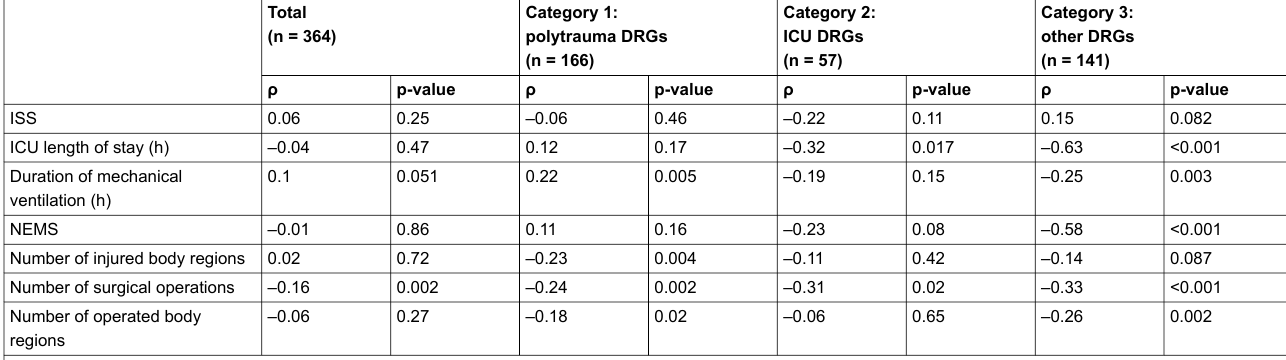
Table S3 : Univariate analysis of the correlation of predictive factors with average profit/deficit per DRG category for continuous variables. Profit/deficit based on case weights from SwissDRG catalogue version 3.0, including supplemental payments. Correlation was analysed with Spearman’s rank correlation (ρ ).